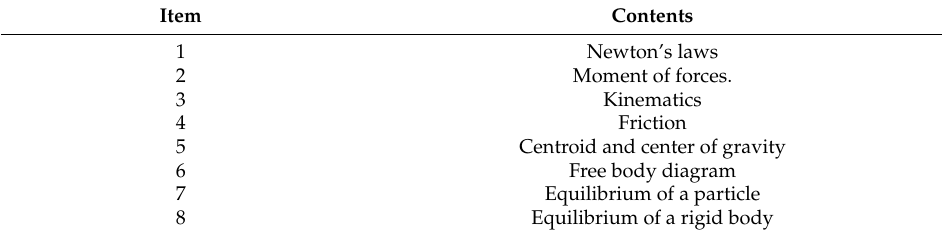
Table 2. Syllabus of the physics extension